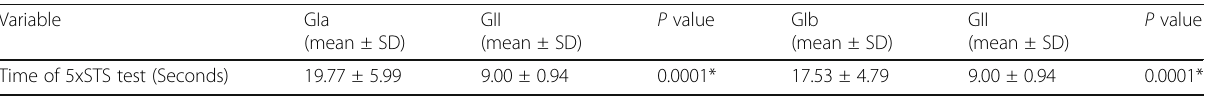
Table 4 Mean values of time of five repetitions sit to stand test in three groups